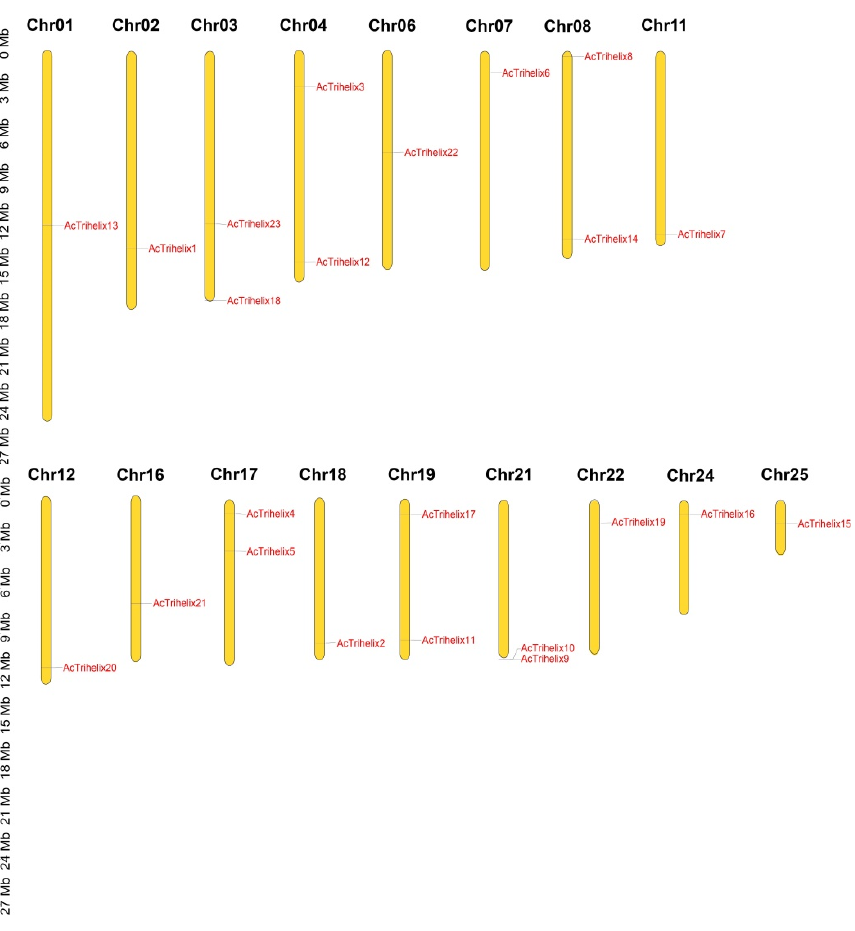
Figure 4. Distribution of AcTrihelix genes in pineapple chromosomes, showing that 23 AcTrihelix genes were distributed on 17 chromosomes. The yellow vertical bars represent the chromosomes (Chr) in pineapple genome. The left scale bar is the length of the chromosome.